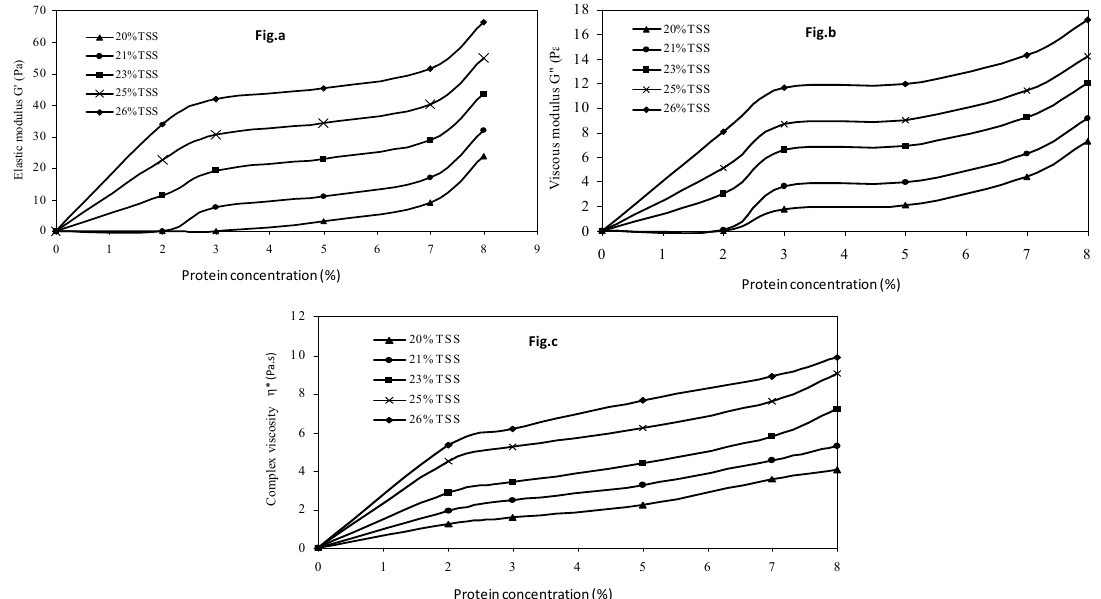
Figure 8. Predicted individual effects of soluble solids and protein concentration on ( a ) elastic modulus, ( b ) viscous modulus and ( c ) complex viscosity at 500 MPa and 3 min holding time.